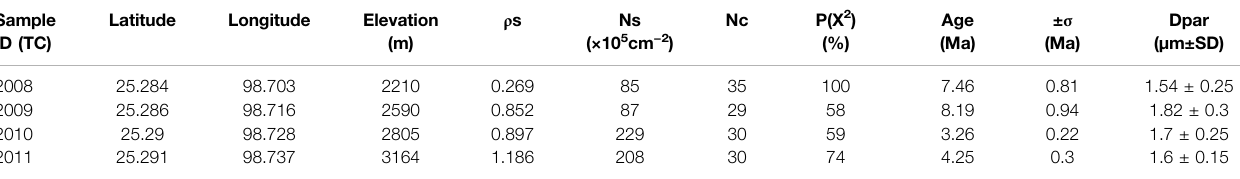
TABLE 4 | Results of the fi ssion track analysis of apatite in the Gaoligong ductile shear zone(GLGSZ). Sample ID (TC)